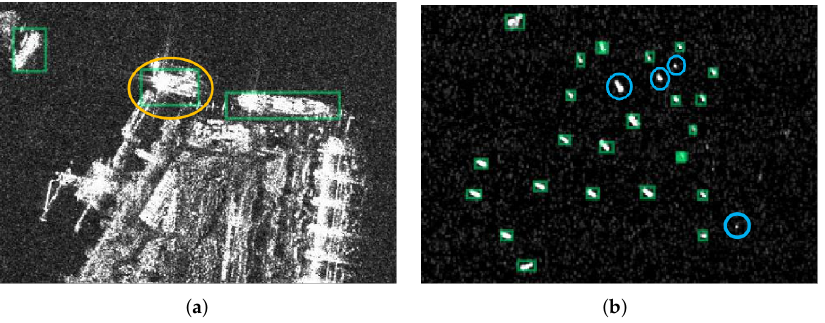
Figure 1. Some undesired detection results under typical scenes from RetinaNet [26]. The spring- green rectangles represent the detection results. The orange and blue circles represent the false alarms and the missing ships, respectively. ( a ) False alarms in complex scenes. ( b ) The missing small